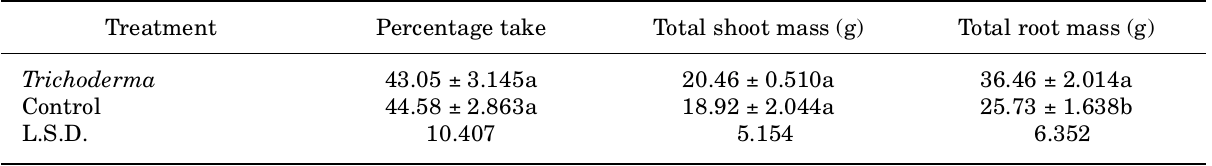
Table 1. Mean percentage take and total root and shoot masses of Trichoderma treated and standard treated (con- trol) nursery